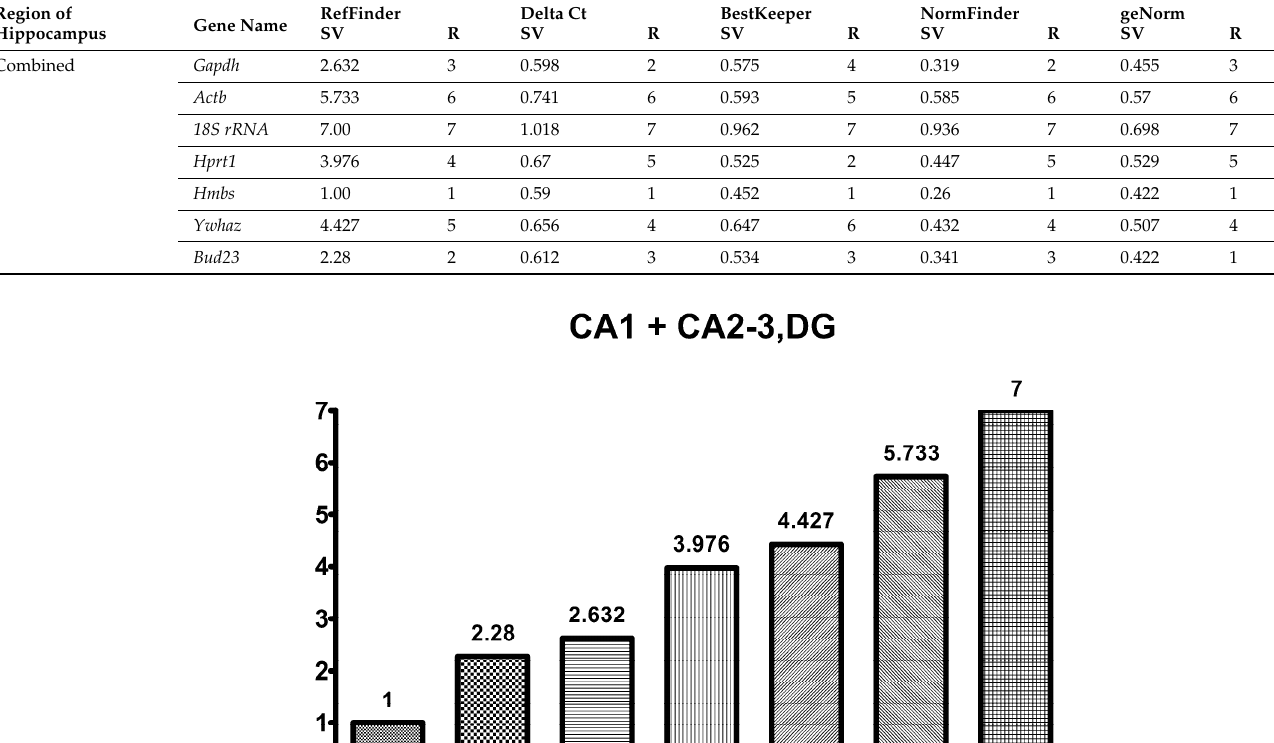
Table 2. Stability value of reference gene from RefFinder and each algorithm. The term Combined rep- resents the results of analysis for all samples, from CA1 and CA2-3,DG regions of gerbil hippocampus. SV and R stand for stability value and rank for each method, respectively.